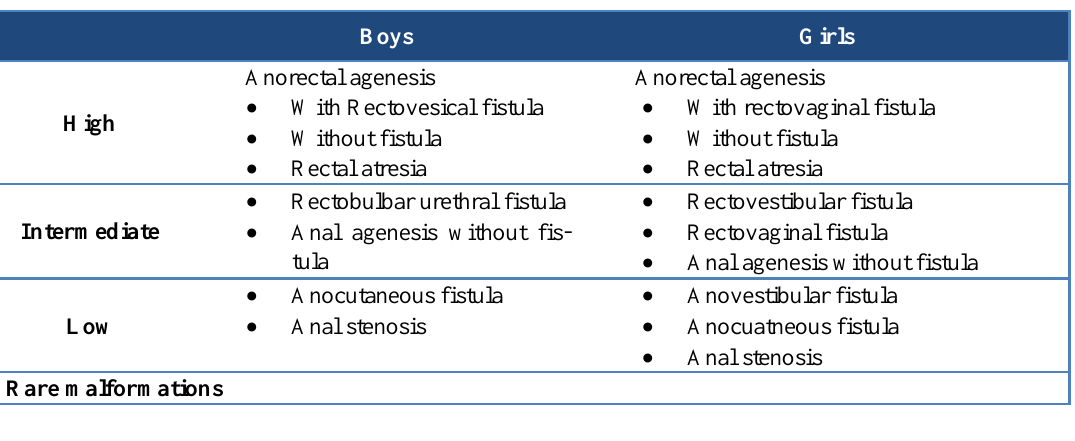
Table 2: Wingspread classification